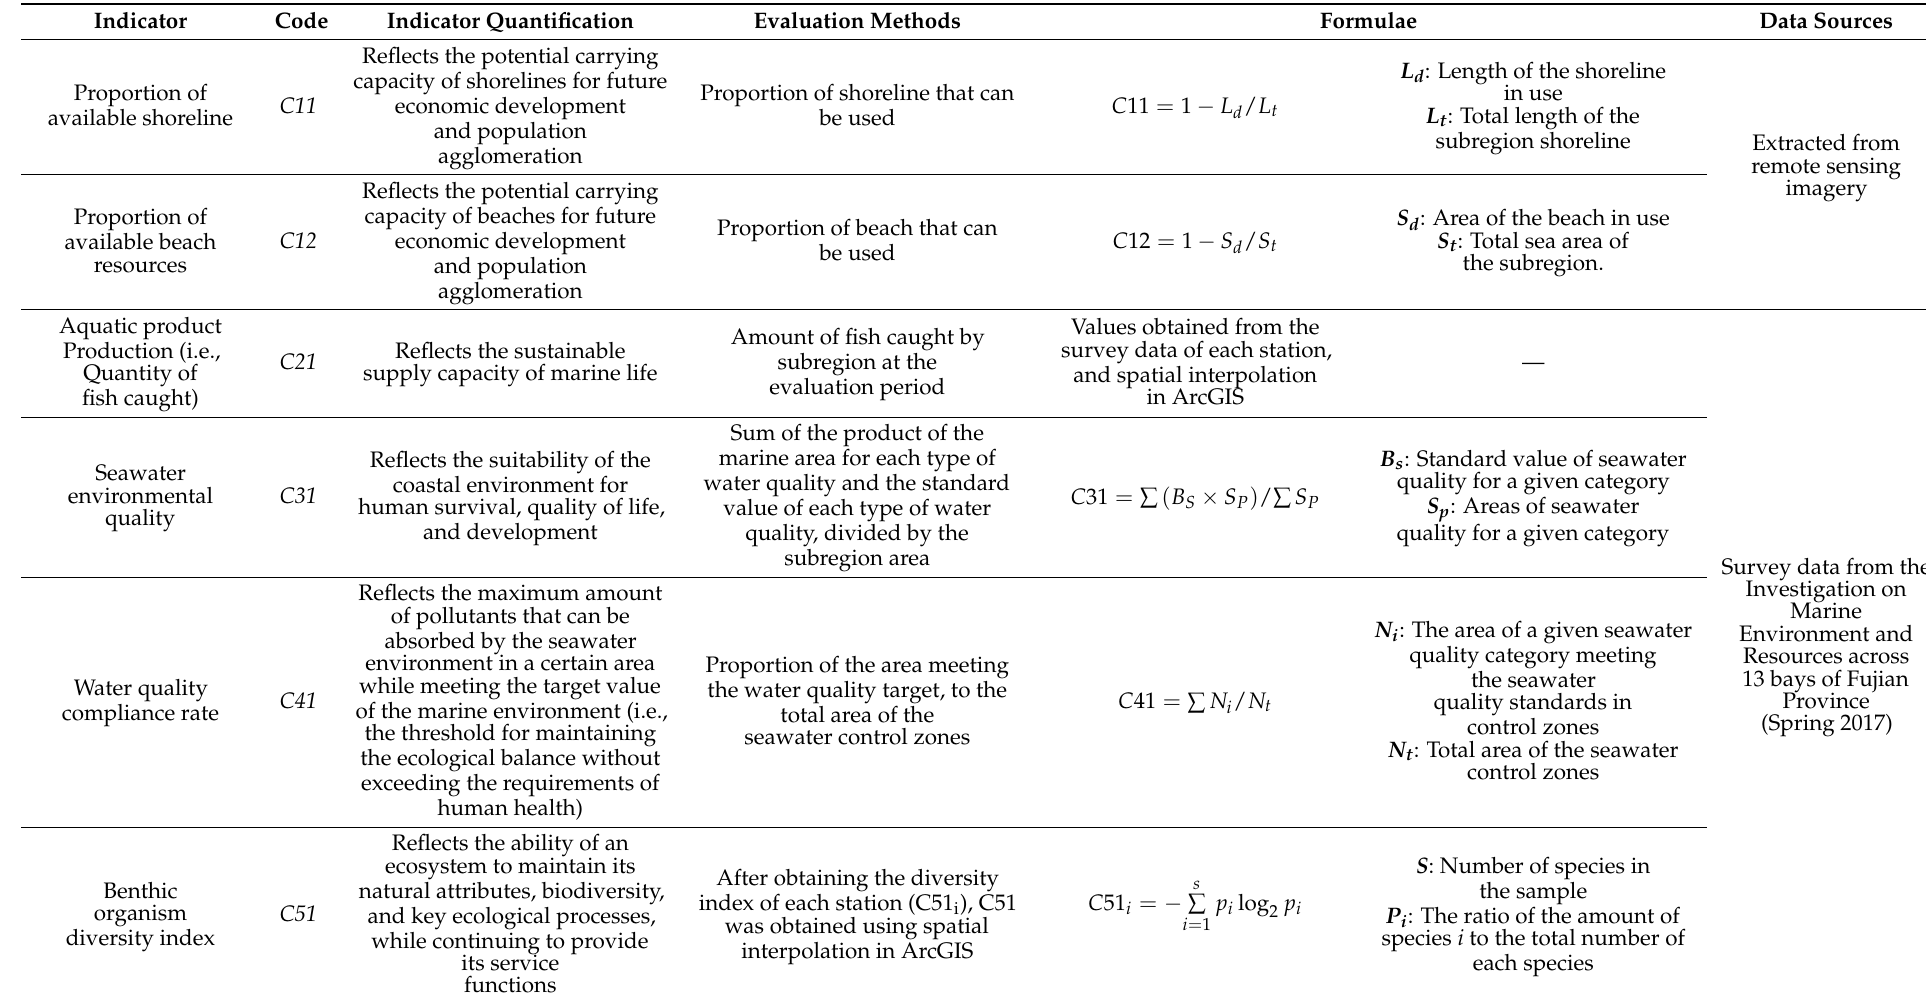
Table 3. Indicator quantification methods and data